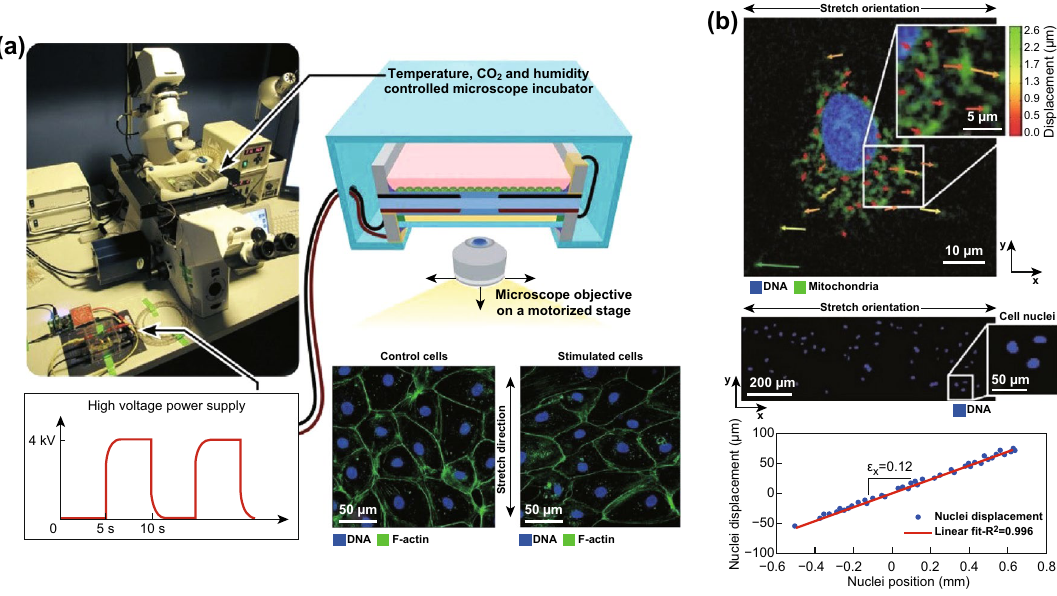
Fig. 9 Real-time monitor system through DEA devices. a Schematic of the whole system with DEA-based cellular stretcher and inverted micro- scope. The DEA is motivated and controlled by the high-voltage source, a mini incubator is used to provide the standard environment for living cells (lymphatic endothelial cells (LECs) used), and the microscope is used to monitor the cells. Adapted from Ref. [44] with permission. b Imaging of lung cells A549 during stretching: The DNA and mitochondria are stained as blue and green, respectively. Top picture shows dis- placement track of the intracellular content of A549 at ×40 magnification; the arrows with different colors and lengths refer to different degrees of displacements. Bottom picture shows the nucleus track of A549, ε x = 0.12 along the stretch orientation measured through this method, and a line is found to fit the nuclei displacement perfectly. Adapted from Ref. [78] with